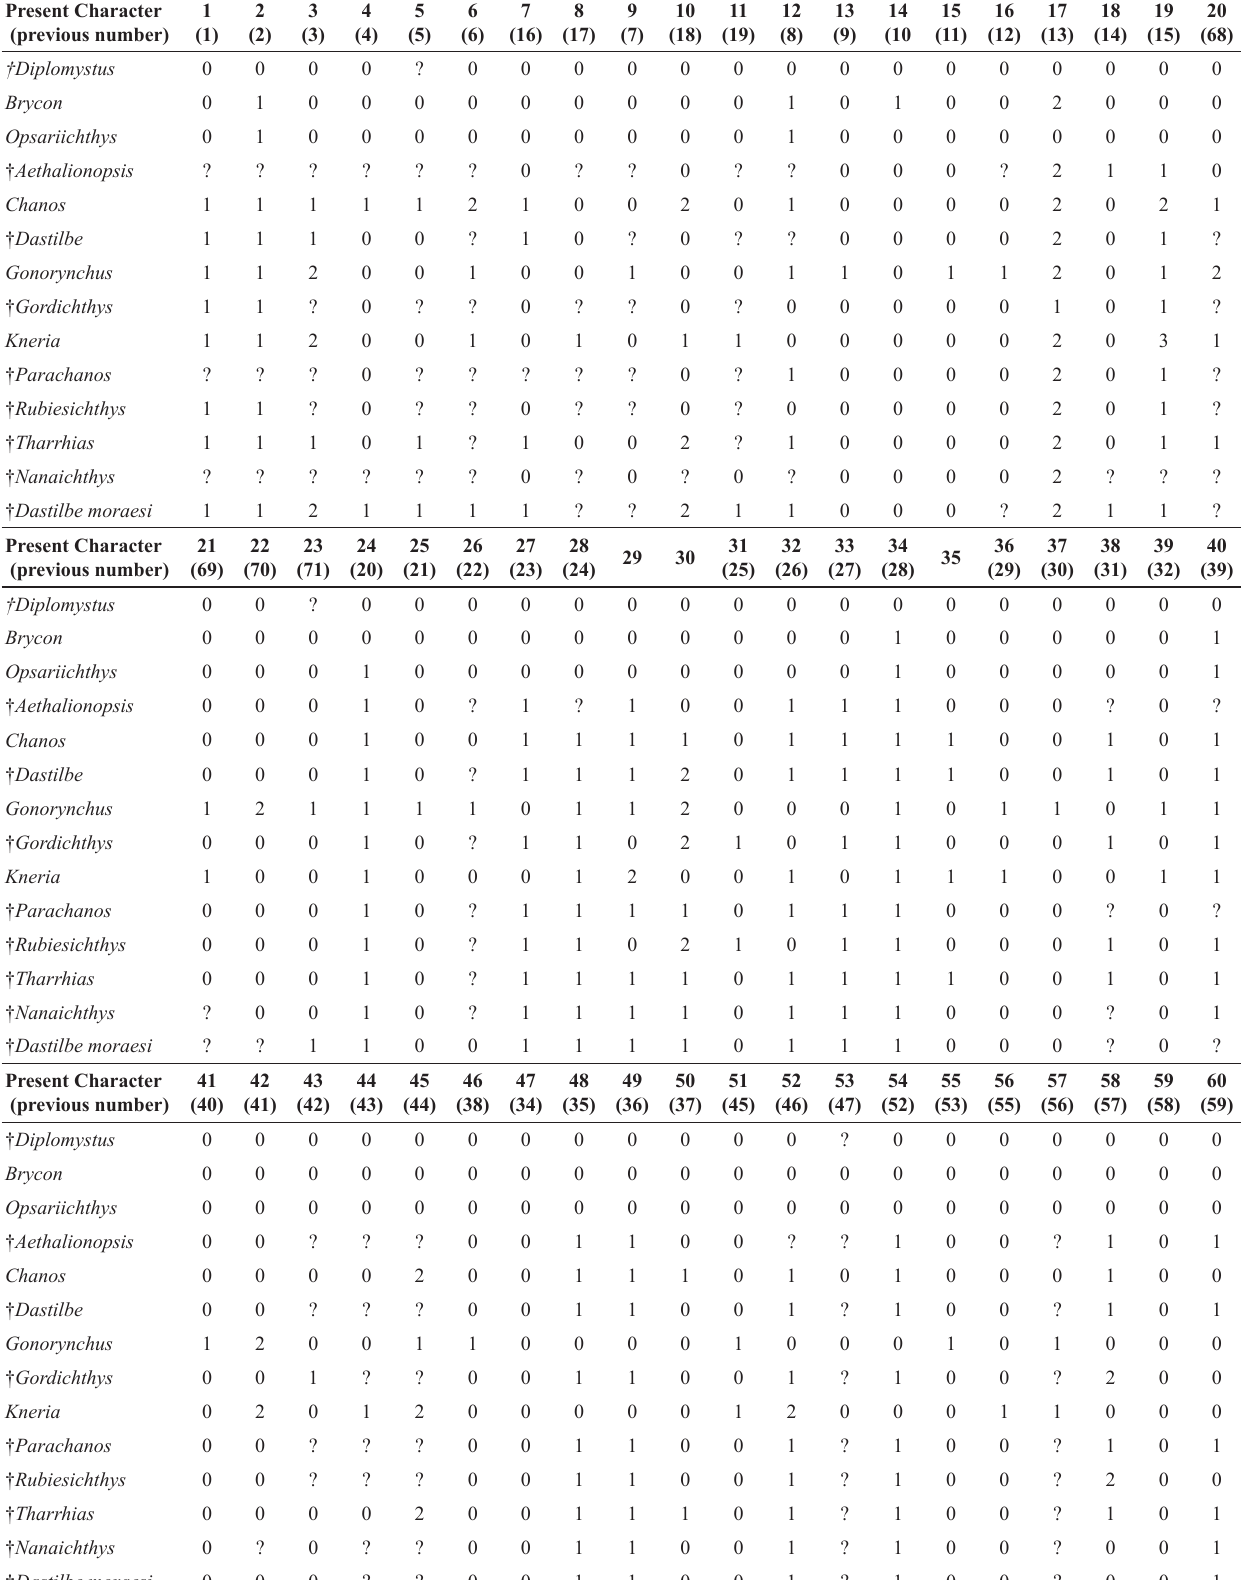
Tab. 1. Data matrix for 14 taxa and 106 characters used in the present phylogenetic study, revised from Poyato-Ariza et al . (2010) ( S1 ). Original character numbers in the data matrix from that article are indicated in brackets. Present Character (previous